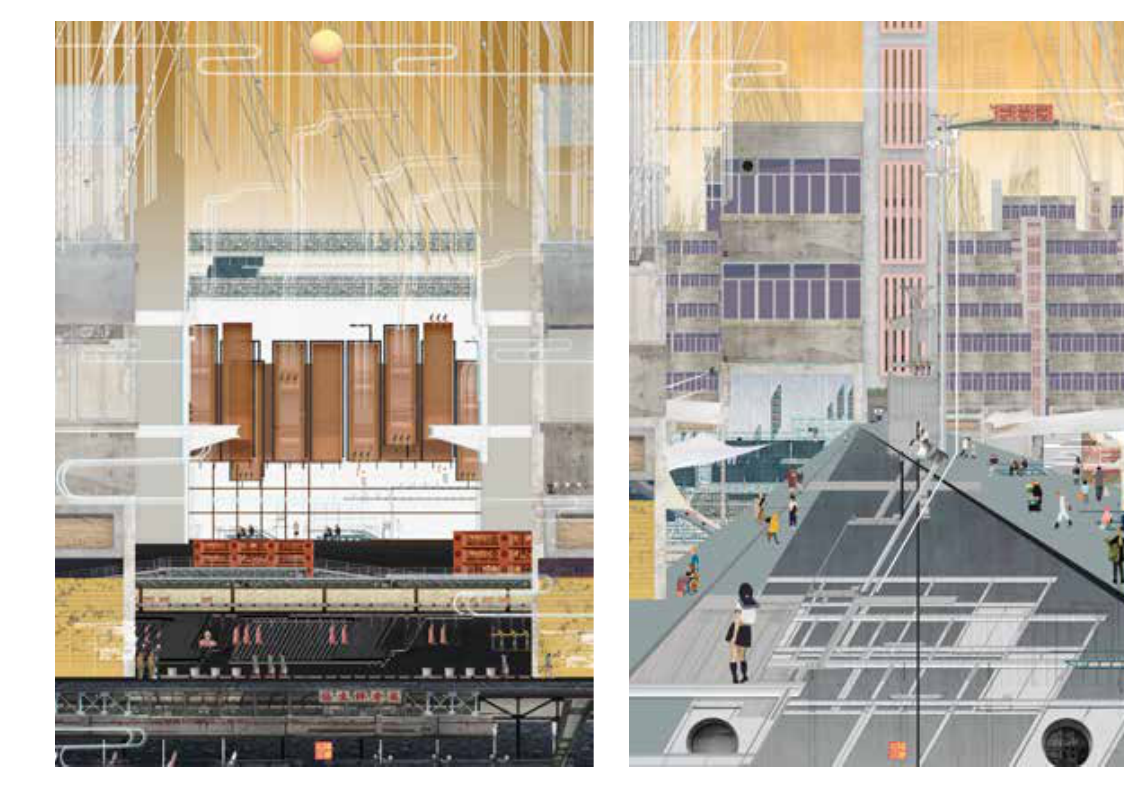
Figure 6: While the restaurant completes preparation of food, a desk and cooking device appear and extend on street. They transform into a private cha chaan teng, an independent bar- becue stall or an open tea house. Walk down a narrow alley, there is an obscure and quiet courtyard. People come here with small amount of food which can be to-be-expired food from market or from home to exchange for a meal with varie- ty of nutrition. (a meal with strangers on a big circular table). Source: Olivia Chen.